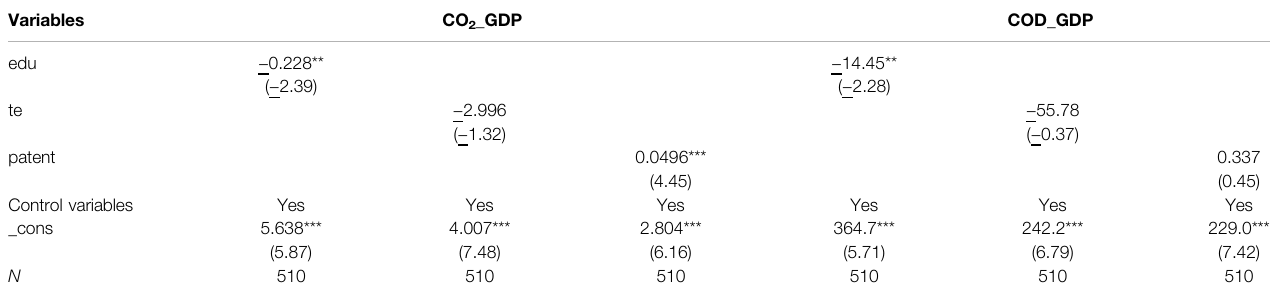
TABLE 11 | Robustness test (two − way fi xed OLS model). Variables